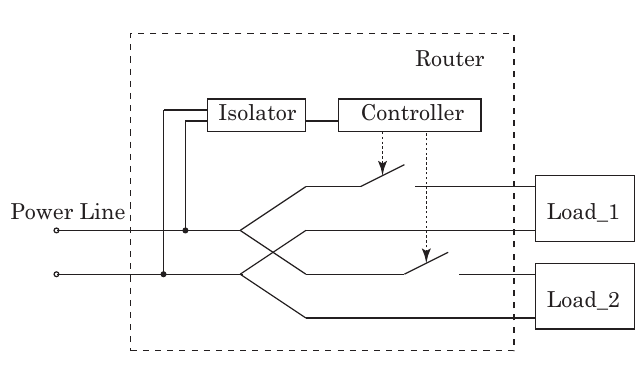
Figure 4. Schematic of the router.